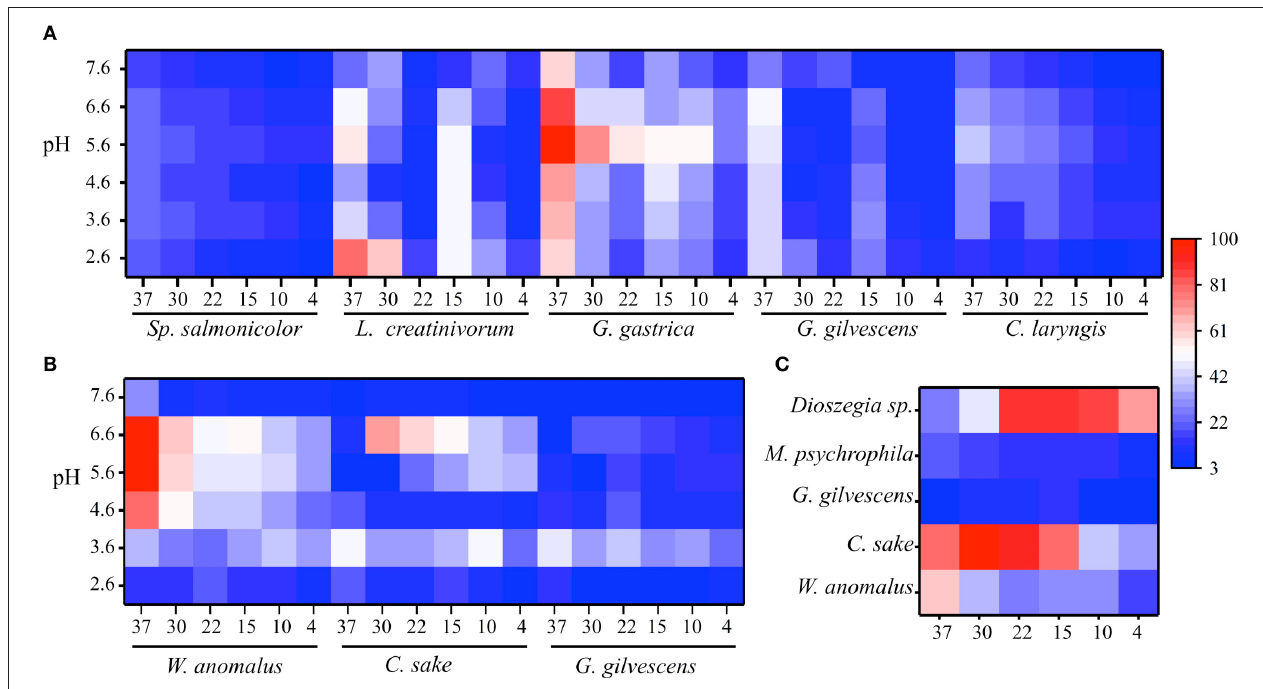
FIGURE 1 | Enzyme activities at different temperature and pH. Enzyme activity levels were determined as the change of absorbance at 500nm for GOD (A) , 540nm for Inv (B) , and 405nm for ALP (C) and normalized by total protein amount in each sample (indicated in Table 1 ). In each case, the percentages were calculated considering as 100% the highest activity that was measured under each condition among yeasts species. In each heat-map, the x-axis is the temperature (Supporting data in Table S2 ). The substrate concentration used was 280, 100, or 5mM of glucose, sucrose or